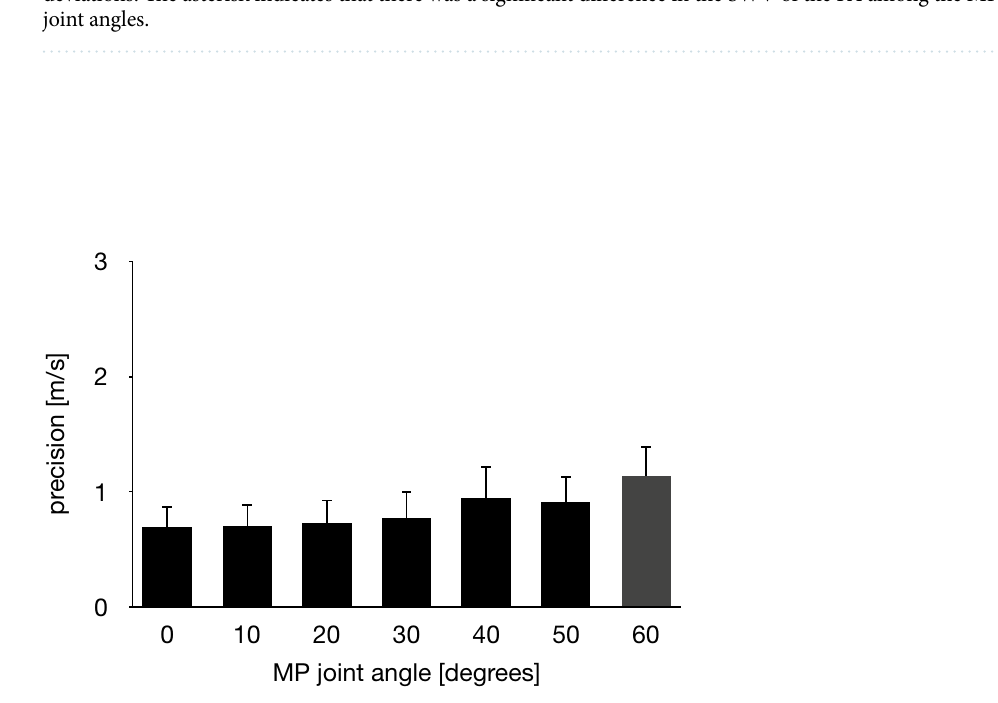
Figure 7. Precision of the SWV measurements of the PA. Error bars indicate standard